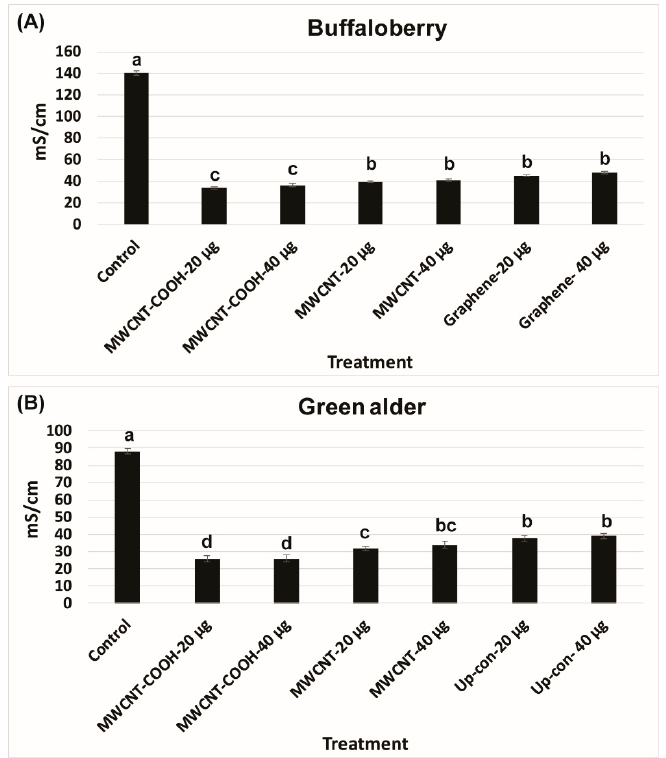
Figure 2. Electrical conductivity (mS/cm) test in buffaloberry ( A ) and green alder ( B ) upland boreal forest species. Values in bar chart represent means ± standard errors. Letters indicate significant difference at α = 0.05. Control = no CNPs added. MWCNT–COOH = multiwall carbon nanotubes functionalized with carboxylic acid, MWCNT = multiwall carbon nanotubes and Up-con = up-conversion nanophosphors.